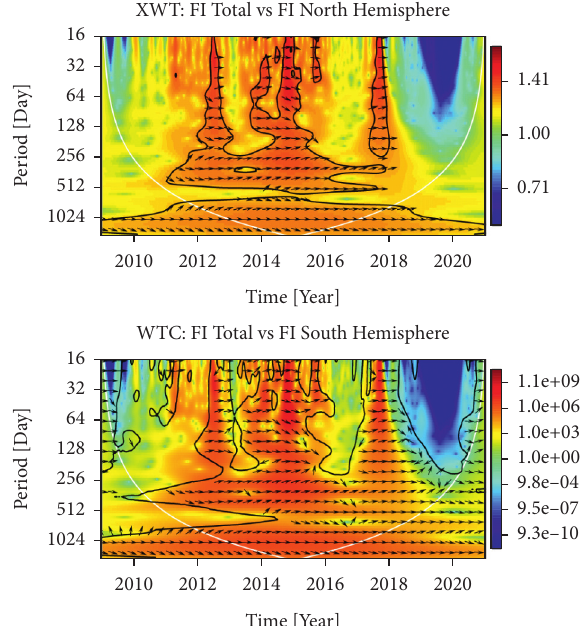
Figure 7: XWT (upper panel) and WTC (lower panel) spectrums between whole disk and Southern Hemisphere FI data. The red color represents regions with the most significant interrelation, while blue colors show the lowest dependence between the selected time series. Periodicities obtained outside of the COI for all wavelet plots are usually not reliable. Arrows in the wavelet coherence plots represent the phase relations between the time series. A zero phase difference means that the two time series move together on a particular scale. Arrows point to the right/left when the time series are in phase (antiphase). Arrows pointing to the right-down or left- up indicate that the first variable is leading, while arrows pointing to the right-up or left-down show that the second variable is